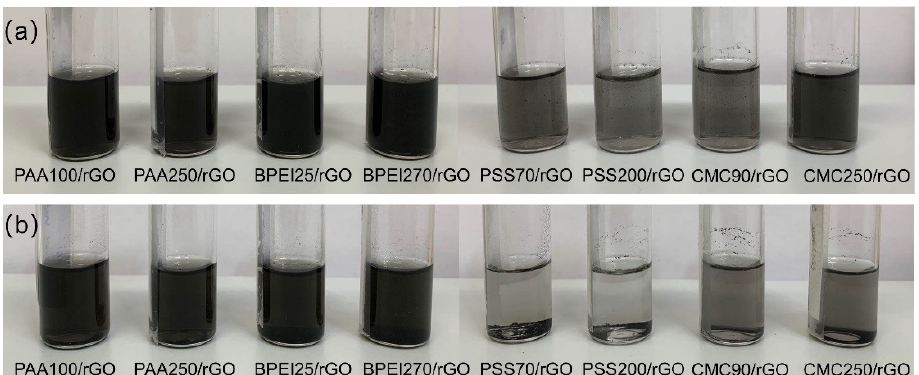
Figure 2. Photographs of rGO dispersed in different polyelectrolyte solutions before ( a ) and after four weeks of aging under static conditions ( b ).